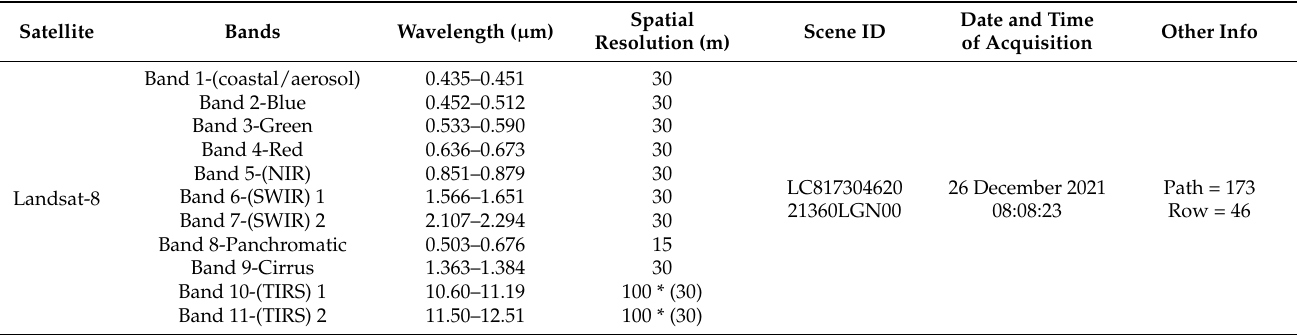
Table 1. Technical characteristics and dataset attributes of different remote sensing